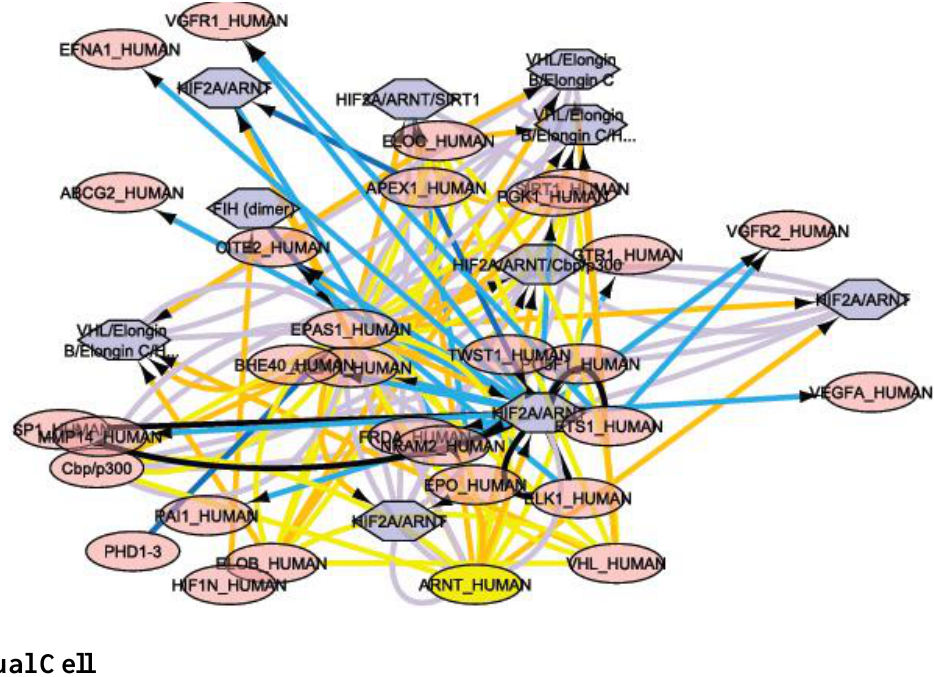
Figure 4. Cytoscape is an open-source bioinformatics software platform for visualizing molecular interaction networks and integrating these networks with other state data. Cytoscape was used to model the interaction networks for VEGF-A (also called vascular permeability factor (VPF). The software found 56 interaction networks at a pathway level, and one of these interaction networks, the HIF-2-α network, is shown with 40 nodes and 114 edges. The importance of this figure is to provide the reader understanding of the level of complexity to which we refer when we speak of interactions at the gene or protein level illustrating this by VEGF-A pathway. Each node represents a molecule that interacts with HIF-2-α; in this case 40 molecules interact with this important marker in different malignancies, through 114